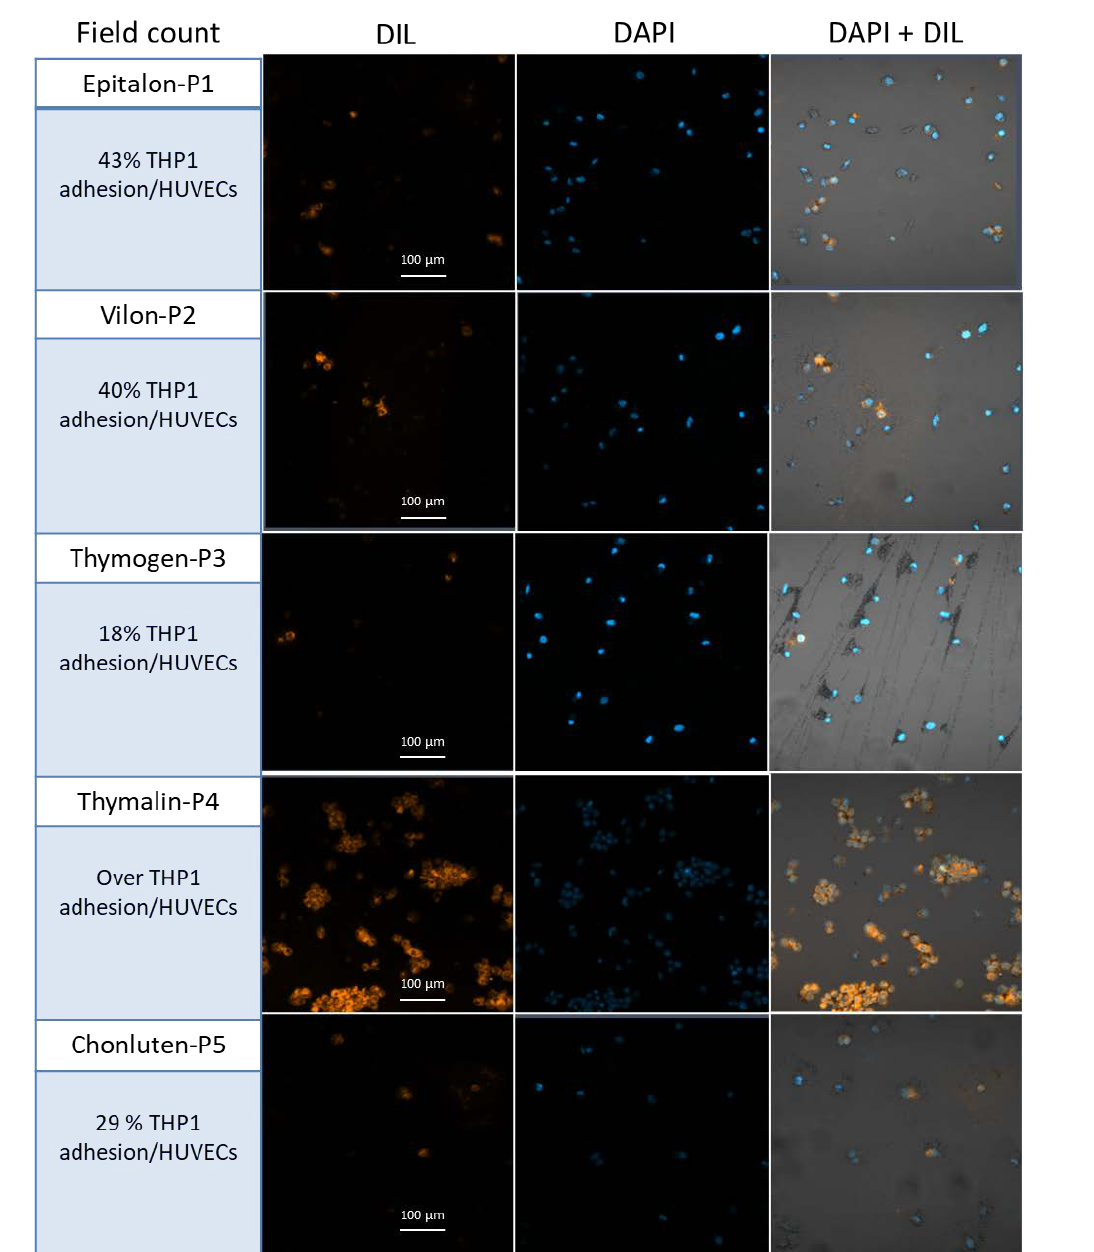
Figure 7. Cell–Cell Adhesion Assay: Confocal microscopy quantification and ICAM-1 Western Blot analysis. ( A ) First column shows fluorescence DIL, the second column shows bright field, the third fluorescence DAPI and the fourth shows fluorescence DAPI + DIL of the same field (20 × ). The negative control shows HUVECs alone (without LPS activation), the positive control shows THP1 monocyte adhesion to HUVECs. (DAPI: 4,6-diamidino-2-phenylindole; DIL: Dioctadecyl-3,3,3,3 -tetramethylindocarbocyanine perchlorate; HUVEC: Human umbilical vein endothelial cell; THP1: THPI monocyte). The scale bar expresses the micrometric reference. ( B ). On the left, bar graph represents the mean of three independent experiments on the effect of peptides on cell adhesion. On the right, Western Blot analysis shows the I-CAM1 induction by LPS-treated HUVECs as proof of adhesion activation. Bar graph shows the mean values of three independent experiments. ( C ) P1 to P5 represent experiment upon peptide treatment of THP-1 monocytes. On the right, percentage of adhesion is shown corresponding to each peptide utilized. On the left, confocal images of fluorescence relative to the adherent monocytes is depicted according to the scheme of Figure 7A, without the bright field images. The scale bar expresses the micrometric